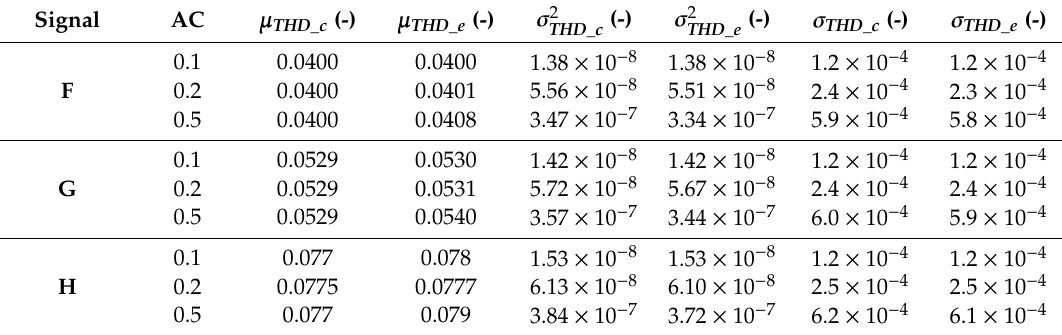
Table 8. Results of the test vs. harmonic amplitude, all at 2% of the 50 Hz component. Signal